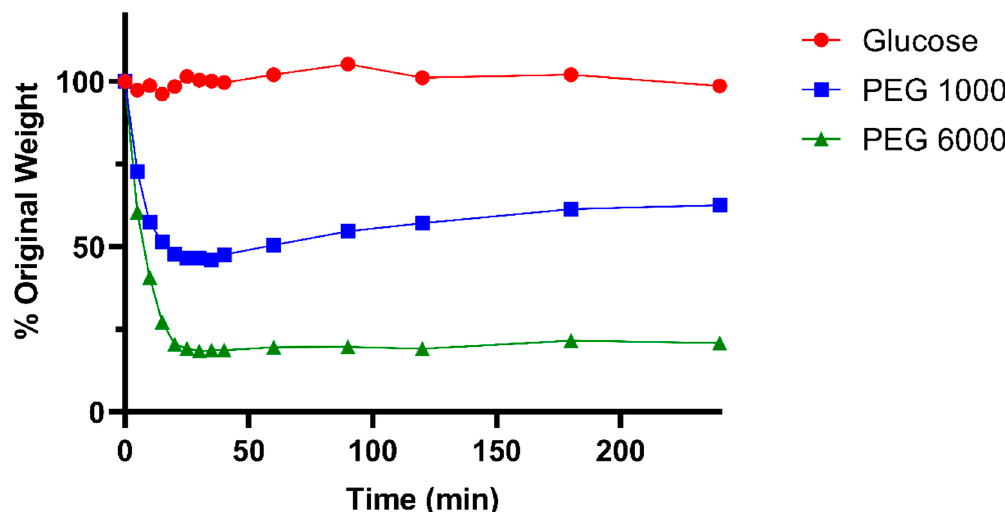
Figure A1. Time course of weight changes in cell walls from sunflower hypocotyls exposed to a water potential of − 0.62 MPa generated by an osmoticum able to permeate the wall rapidly (glucose, red circles), an osmoticum partly excluded from the wall but expected to diffuse through it more slowly than water (PEG 1000, blue squares), and an osmoticum substantially excluded from the wall (PEG 6000, green triangles).